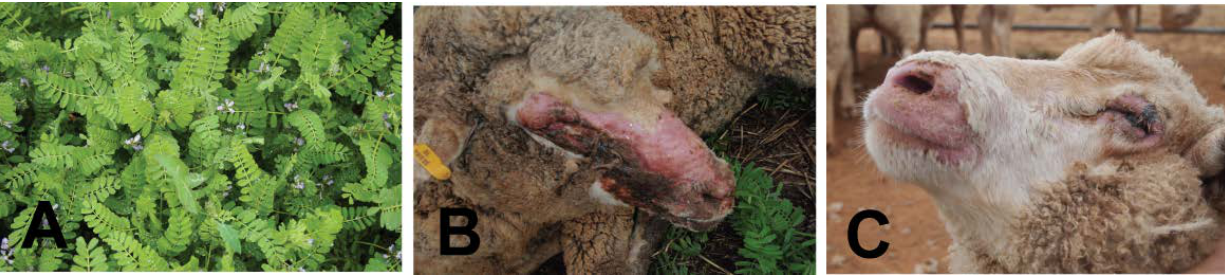
Figure 4. Photosensitization in domestic livestock caused by Biserrula pelecinus L. and Tribulus terrestris L. ( A ) Biserrula pelecinus , a pasture legume crop causing photosensitization in grazing herbivores; ( B ) Severe photosensitization resulting from ingestion of saponins in Australian sheep grazing Tribulus terrestris , also known as caltrop. Note severe impact on eyes and face with severe dermal lesions and tissue swelling and loss of fleece on face and muzzle. Eyes are swollen and produce significant exudates; ( C ) Photosensitization in Australian sheep grazing Biserrula pelecinus “Mauro”. Lesions are less severe as grazing occurred for only 72 h. Note similar loss of fleece around the muzzle and swelling around the eyes with crusty exudate. This example also experienced corneal